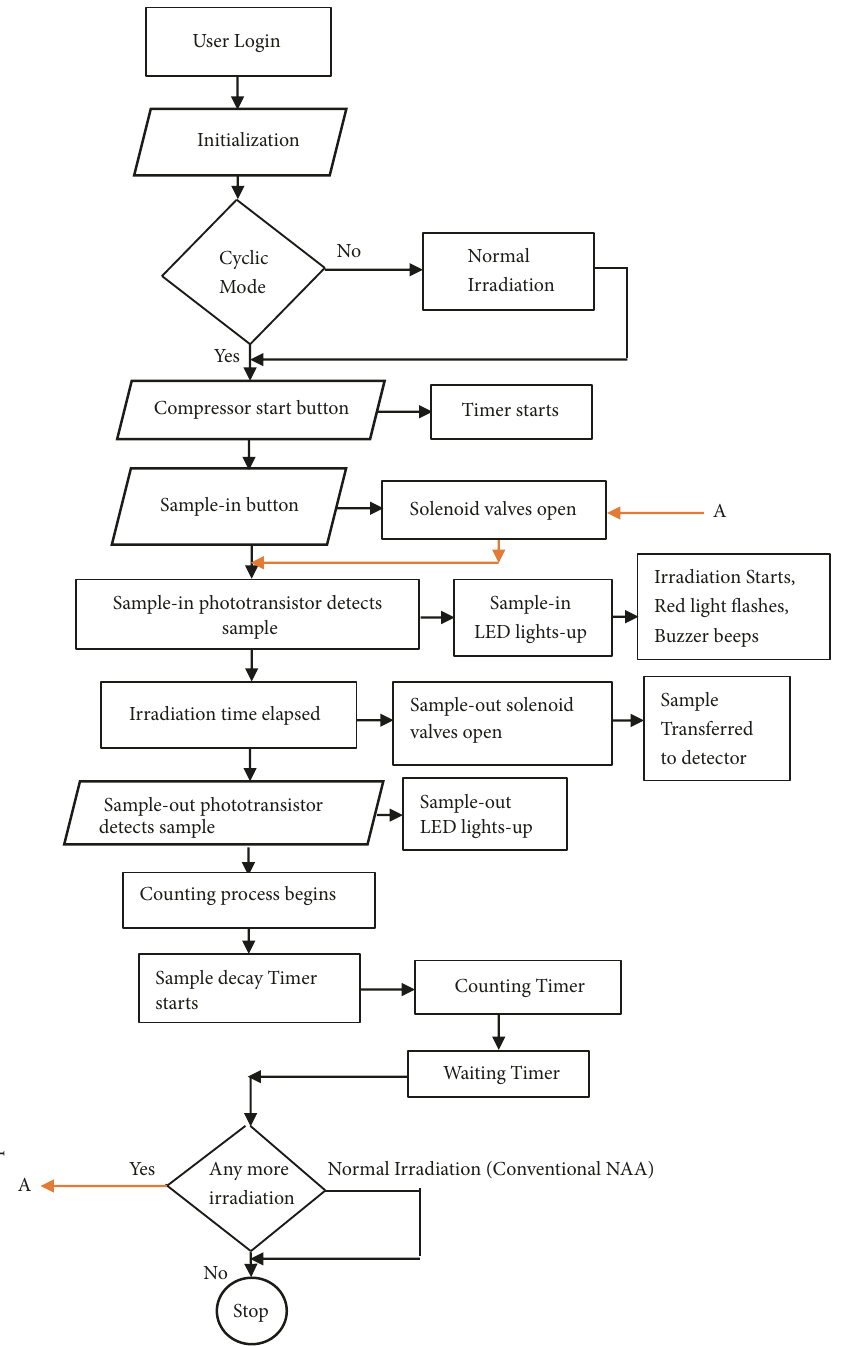
Figure 6: Flow chart for cyclic and conventional mode